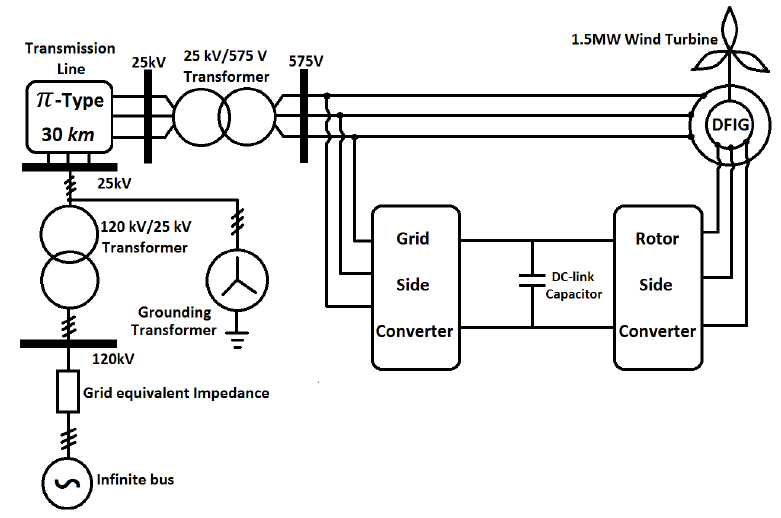
Figure 3. Configuration of the grid-connected doubly fed induction generator (DFIG) wind turbine